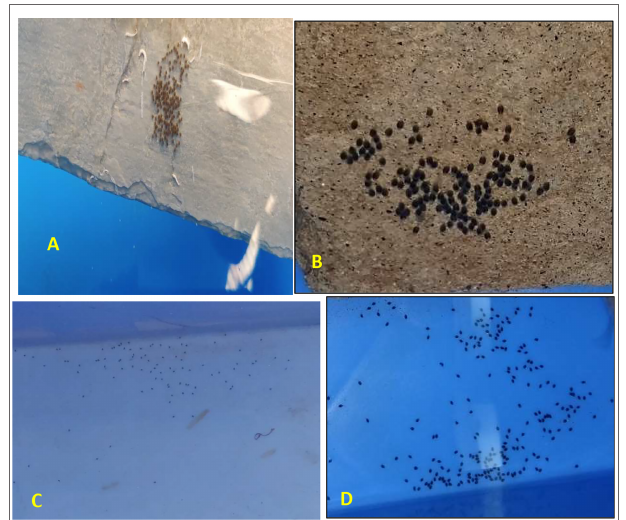
FIGURE 5 | Breeding of P. maculatus in different conditions. P. macuIatus eggs attached to a substrate in (A) Freshwater and (B) Marine water. One day old hatchlings of P. maculatus in (C) Freshwater (D) Marine